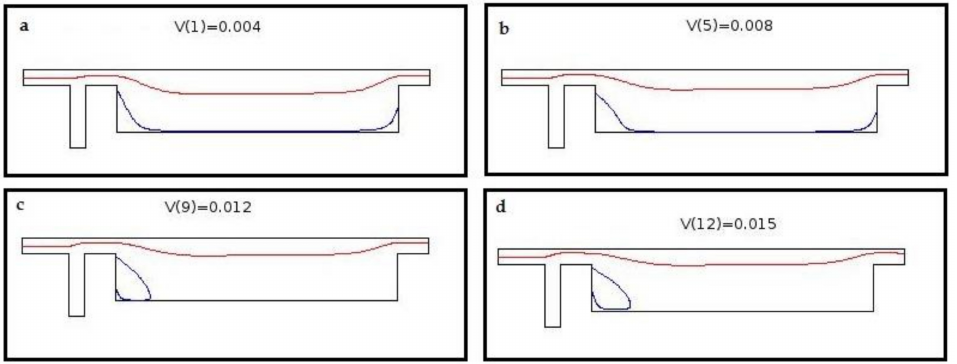
Figure 6. Change in streamlines by increasing velocity of auxiliary channel: ( a ) 4 mm/s; ( b ) 8 mm/s; ( c ) 12 mm/s; and ( d ) 15 mm/s. By increasing the velocity, the streamlines are lifted up and detached from the wall. A circulation zone will be formed above a threshold